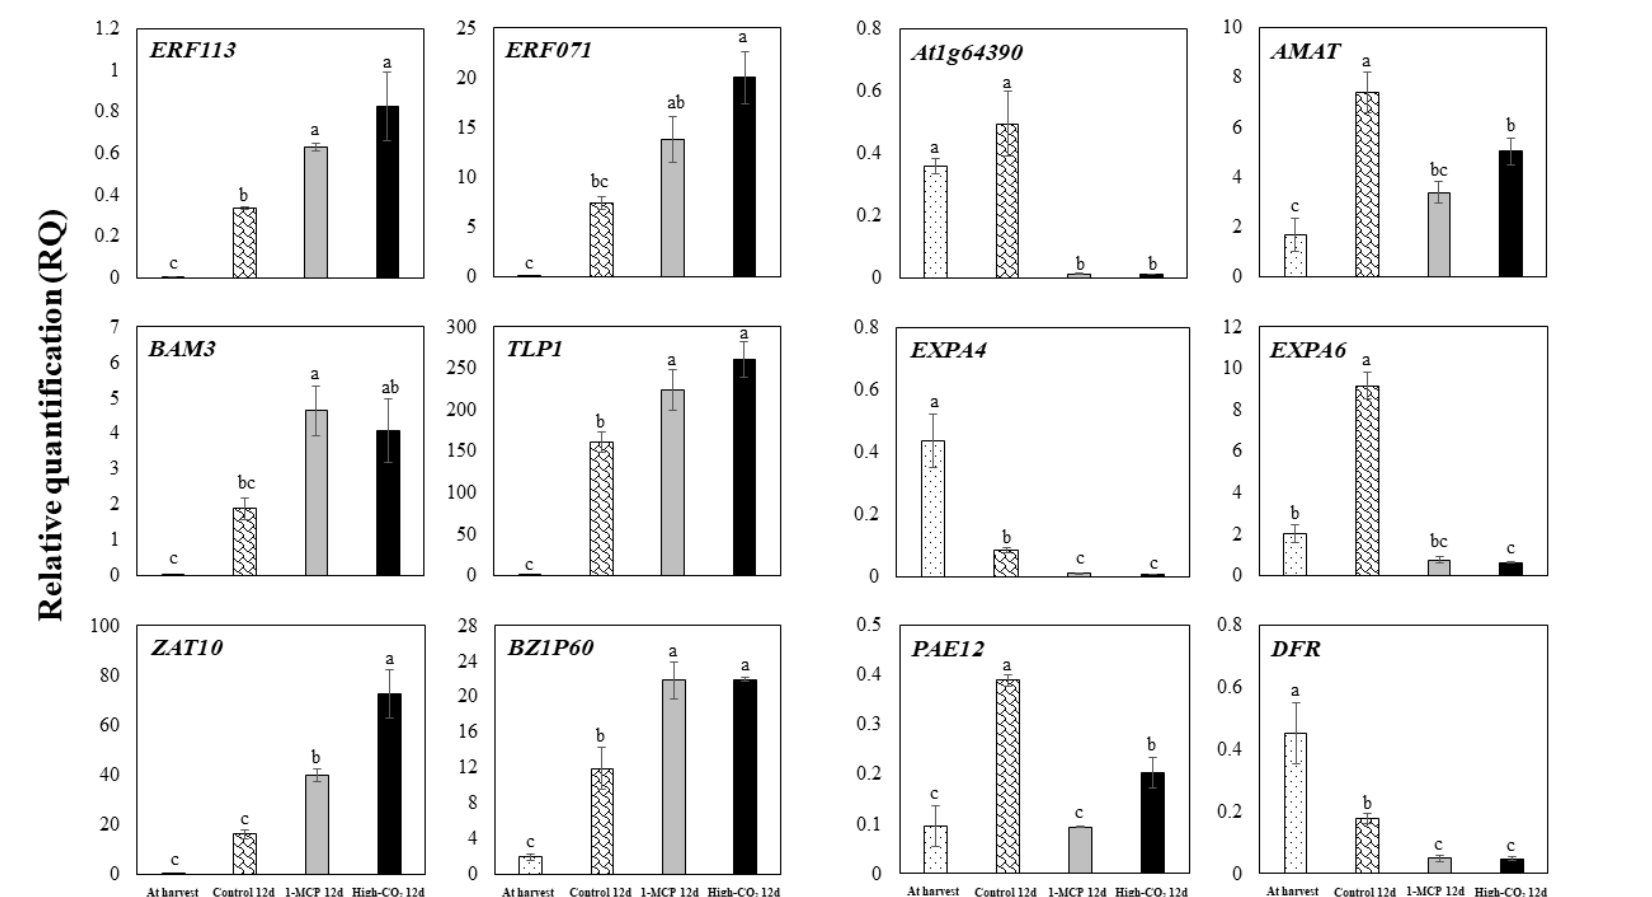
Figure 5. Transcript accumulation of the selected DEGs of ‘Madoka’ peach fruit by qRT-PCR for the comparison of fruit at harvest and after 12 days storage at 0 °C with pre-storage 1-MCP and high-CO 2 treatments or without treatment (control). Vertical bars represent standard errors of the means (n = 3). Different letters on the bars indicate significant difference between treatments with Duncan’s multiple range test at p ≤ 0.05.